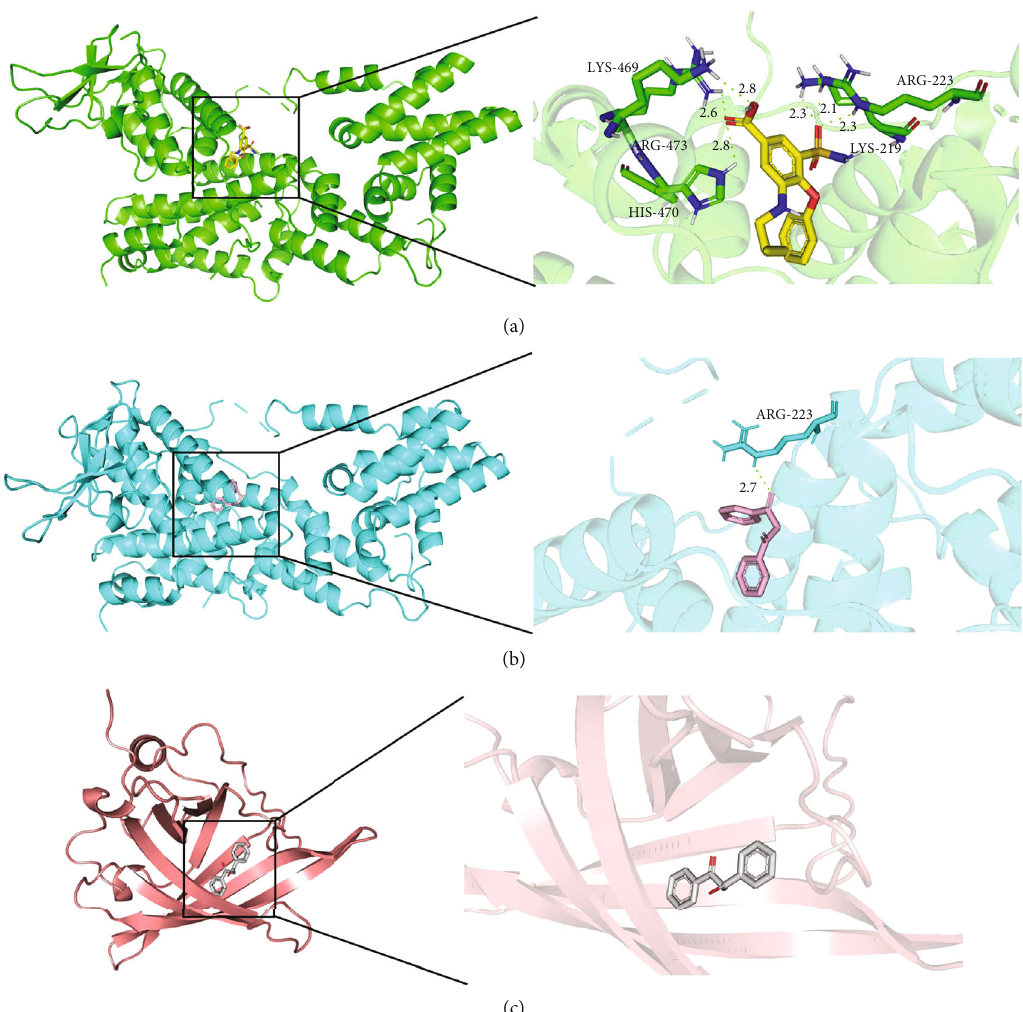
Figure 9: Docking diagram of potential small-molecule drugs with targets. (a) bumetanide-RASGRP1. (b) dibenzoylmethane-RASGRP1. (c)